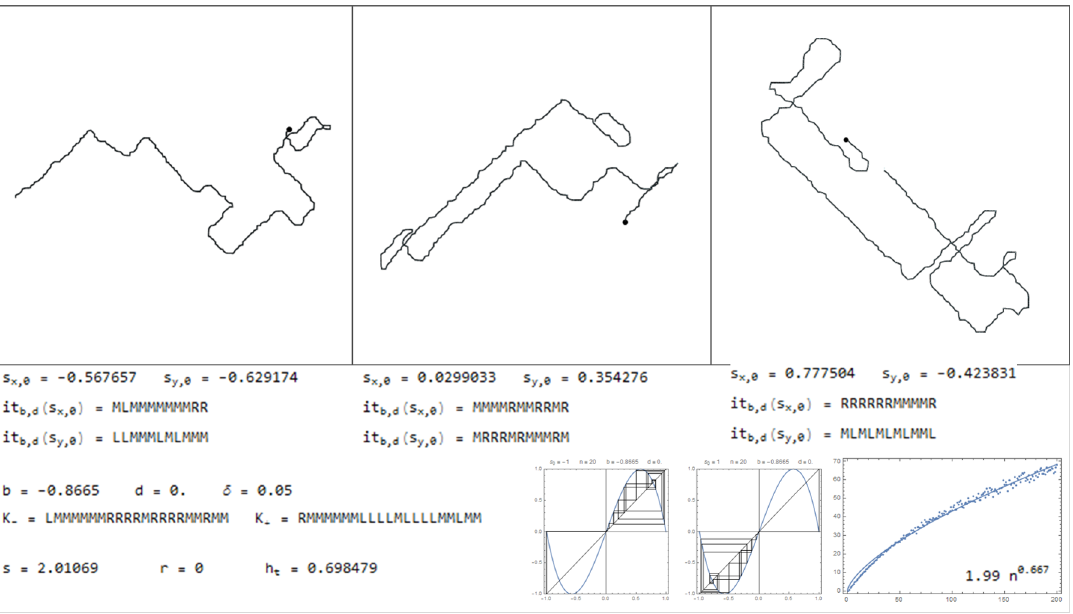
Figure 23. Trajectories produced with b = − 0.8665 and d =